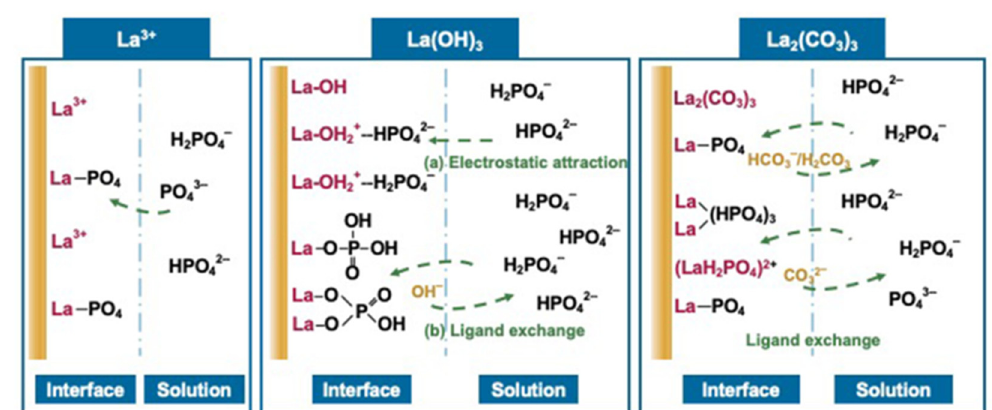
Figure 11. A schematic diagram for the P binding mechanisms of different La species [61].